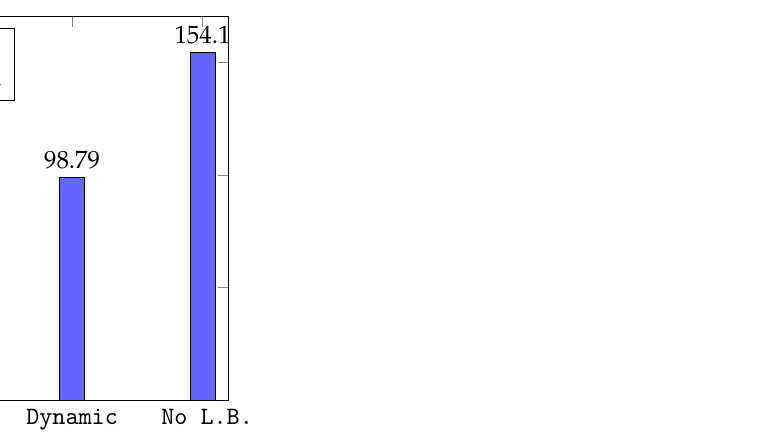
Figure 10. Simulation times of the silo benchmark without and with dynamic and frequent load- balancing schemes.